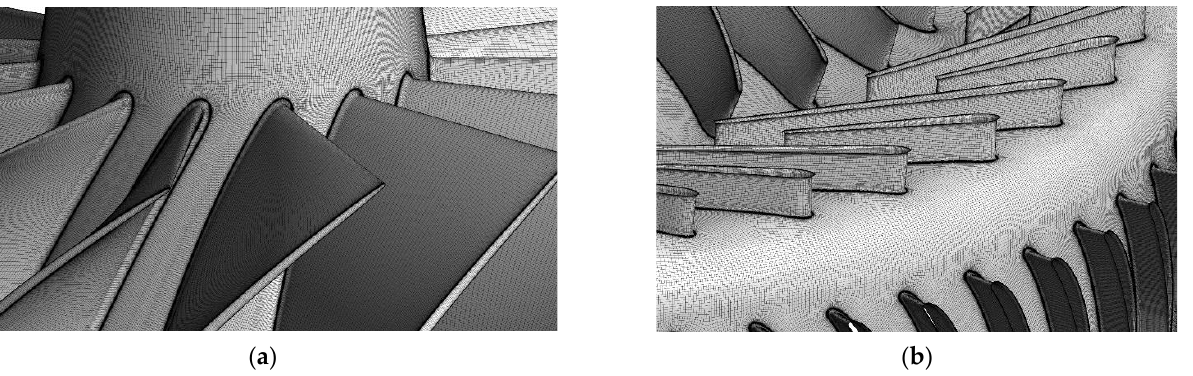
Figure 3. A view of the grid topology (Blade passages are duplicated for better figure quality): ( a ) impeller leading edge; ( b ) diffuser vanes, EGV vanes and 90-degree turn. Table 1. Grid independence